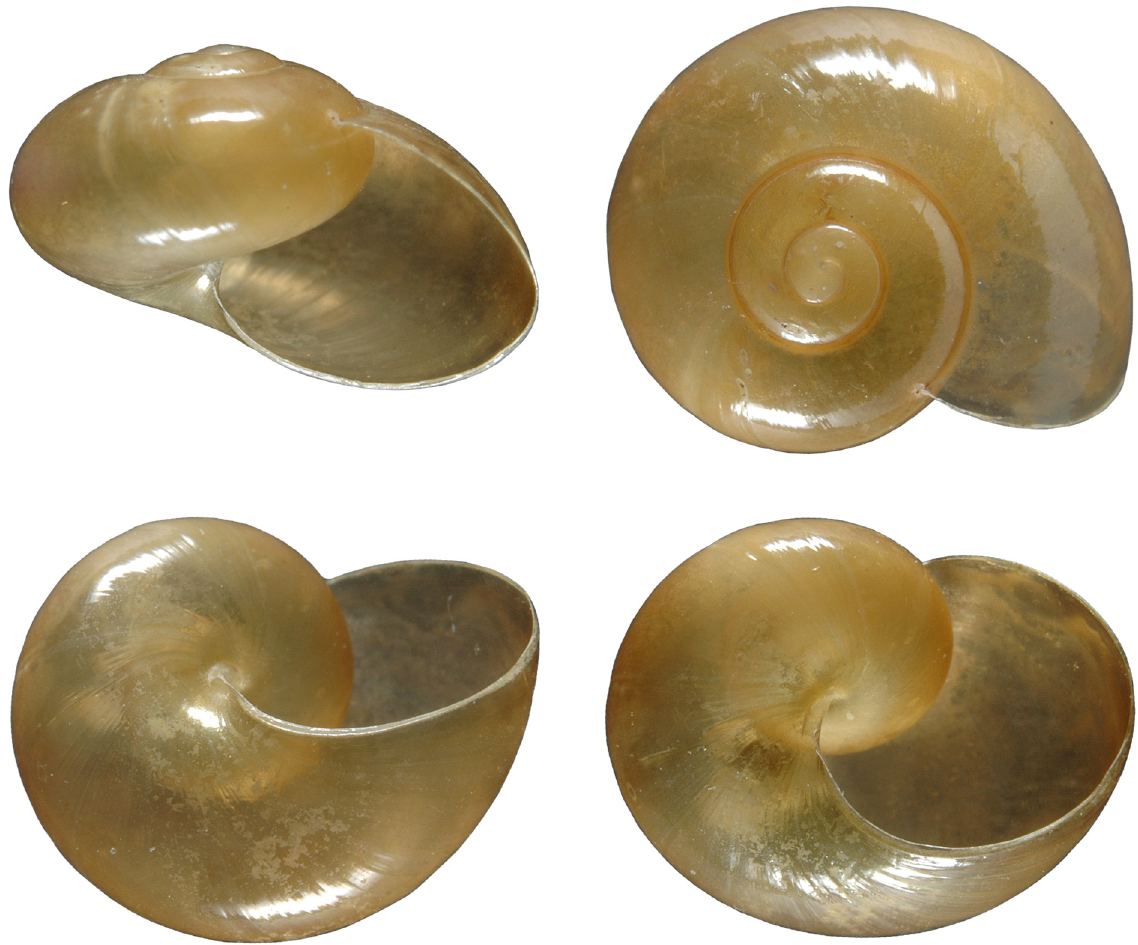
Fig. 13. Sheldonia wolkbergensis sp. nov., holotype, diameter 7.7 mm, height 5.2 mm (NMSA P0156/